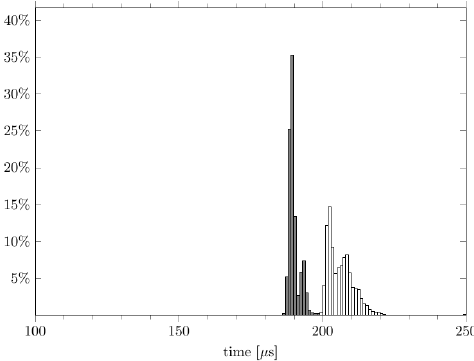
Figure 5. A cycle time histogram for the Python FFT module, both with (white) and without (gray) the action of the garbage